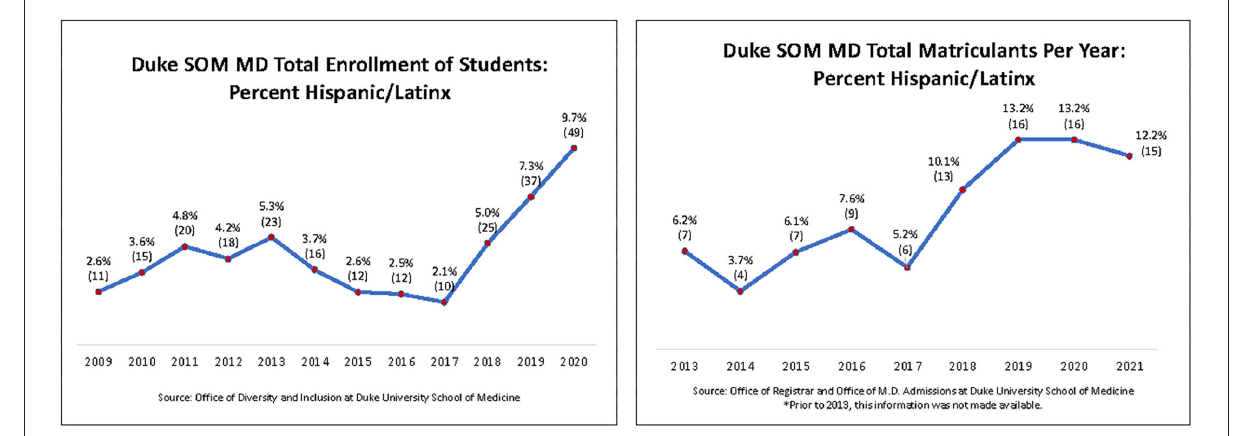
FIGURE1 The left panel shows the percentage of Hispanic/Latinx students enrolled at Duke SOM from 2009 to 2020 as a function of total enrollment. The right panel shows the percentage of Hispanic/Latinx student matriculants per year at Duke SOM from 2013 to 2021 as a function of total